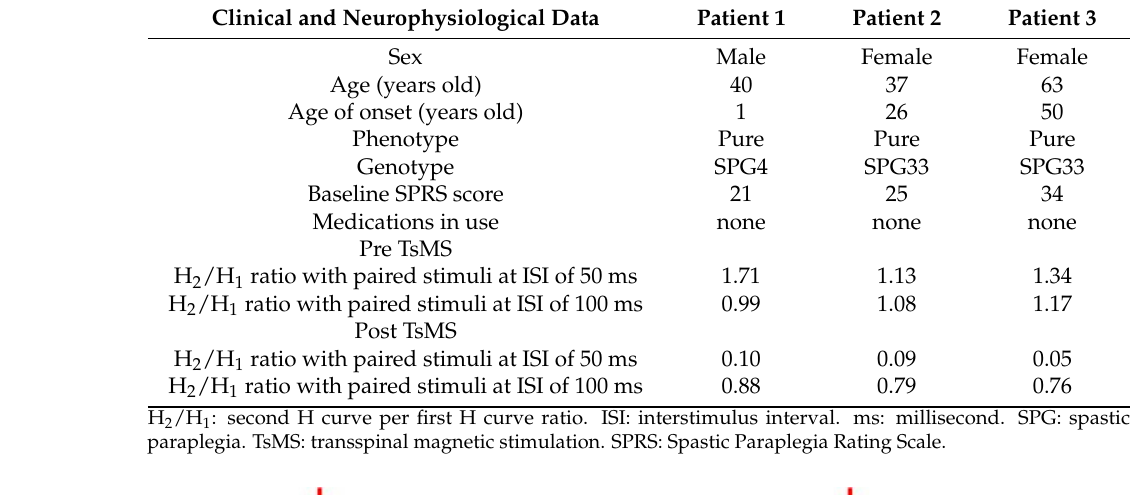
Table 2. Clinical data and neurophysiological responses of hereditary spastic paraplegia patients before and after the TsMS thoracic inhibitory protocol.